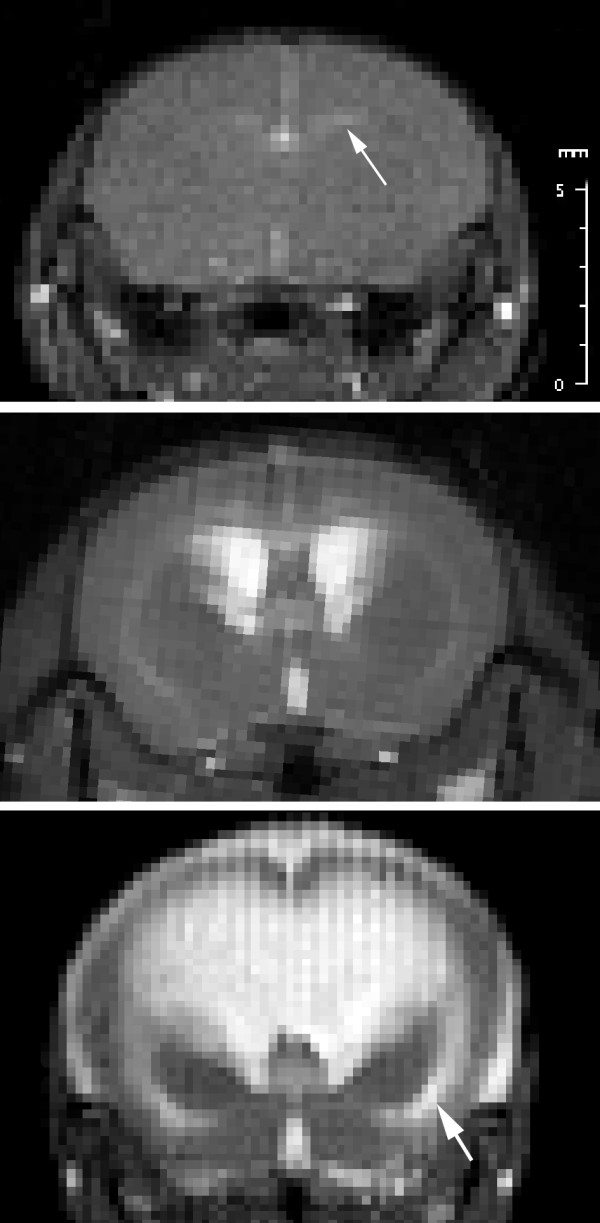
Magnetic resonance imaging of hydrocephalic rat brain. T2-weighted magnetic resonance images showing coronal slices through rat brains at the level of the frontal horns of the lateral ventricles, anterior to the third ventricle. Prior to kaolin injection (upper panel) the ventricles are barely visible (arrow). One week after kaolin injection (middle panel) there is noticeable enlargement of the lateral and third ventricles, and 3 weeks after kaolin injection (lower panel) there is marked enlargement of the ventricles as well as the subarachnoid space. Edema is evident in the external capsule (arrow).